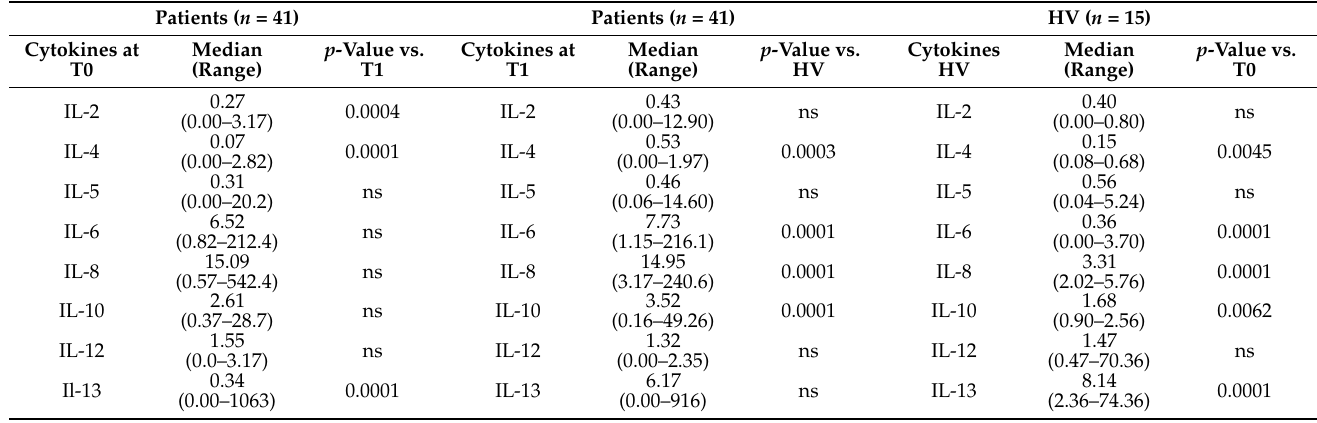
Table 3. Cytokine comparison from T0 to T1 and from both timepoints compared to HV. Concentra- tions are expressed in